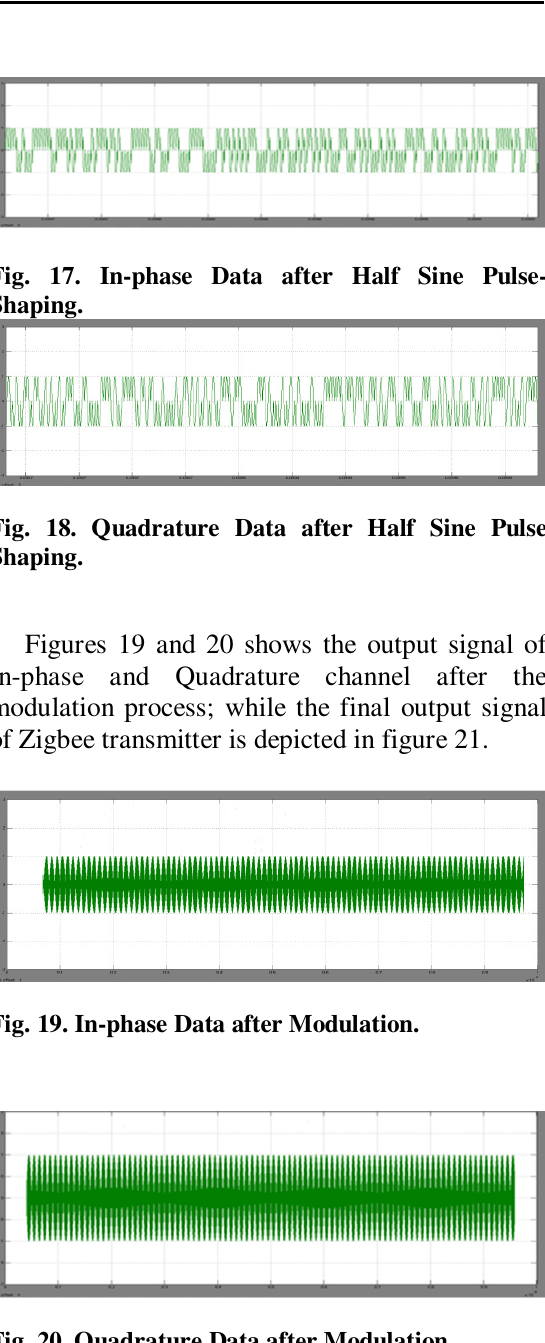
Fig. 15. In-phase and Quadrature Data.